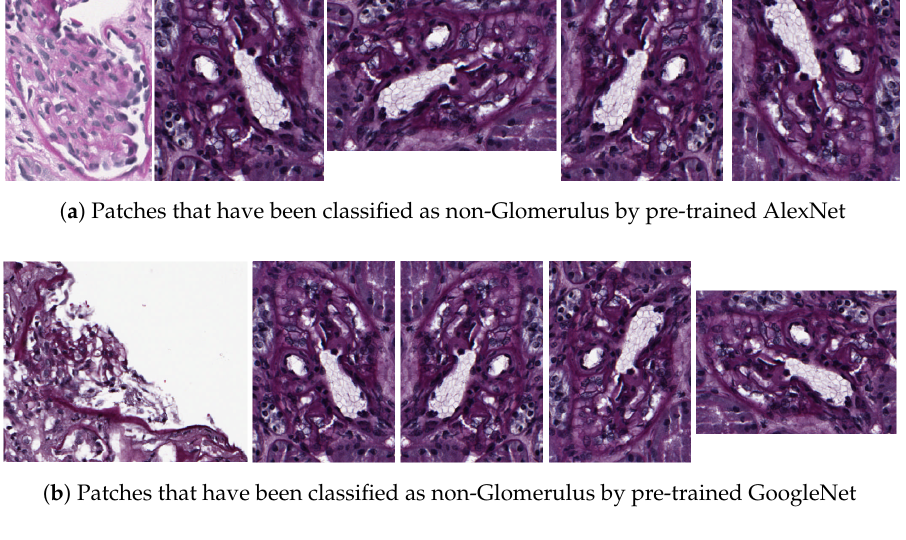
Figure 8. Glomeruli that have been classified as non-Glomerulus by pre-trained AlexNet and GoogleNet